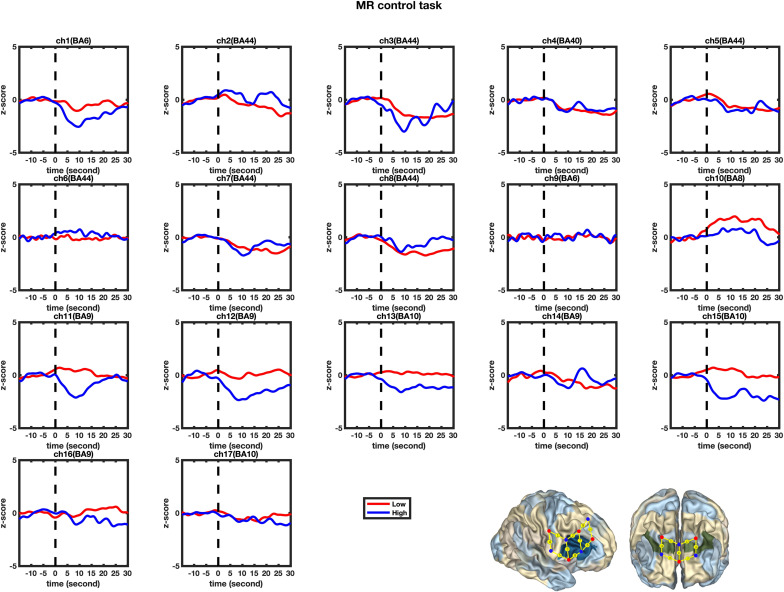
Temporal changes in the HbO concentration in the 17 channels during the Control tasks. From left to right are channels 1–17. The HbO data for the Low-MWC (N1 = 18) and High-WMC (N2 = 9) are shown in the blue and red lines, respectively.